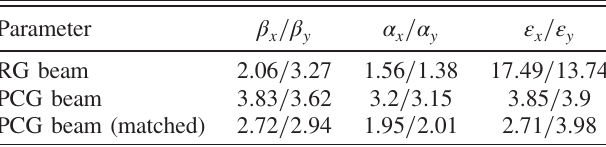
TABLE II. Result for emittance and Twiss function